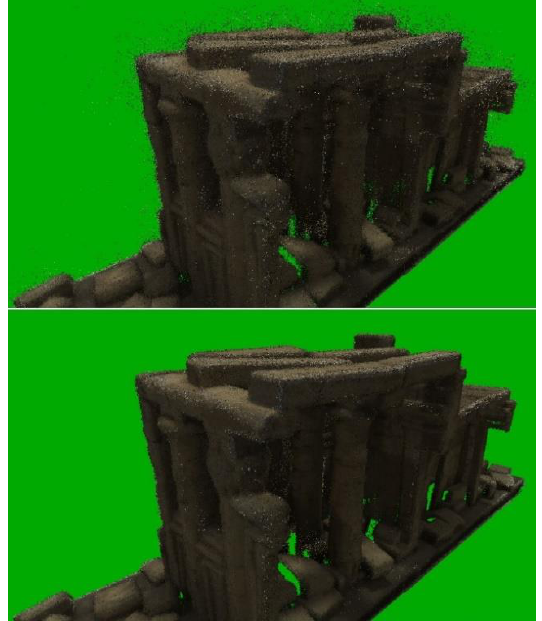
Figure 11. Point cloud before (top) and after (bottom) the SOR algorithm